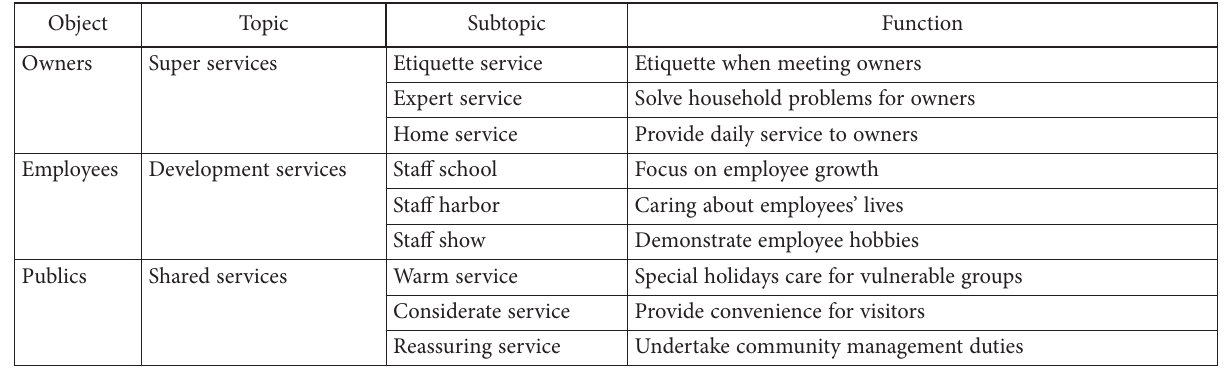
Table 3. Topics and their functions of pleasure service